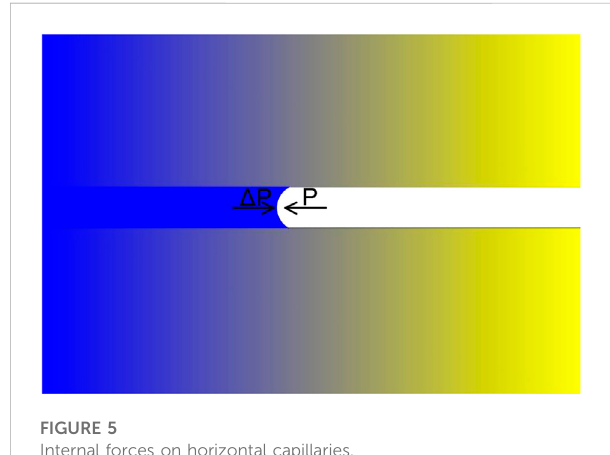
Internal forces on horizontal